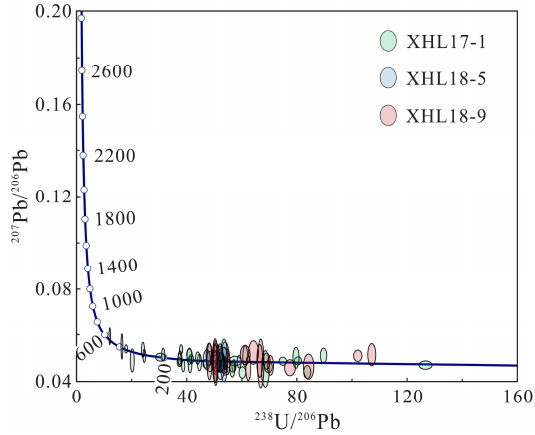
Figure 8. Zircon U−Pb age distribution of granite plutons in the Xianghualing ore field.